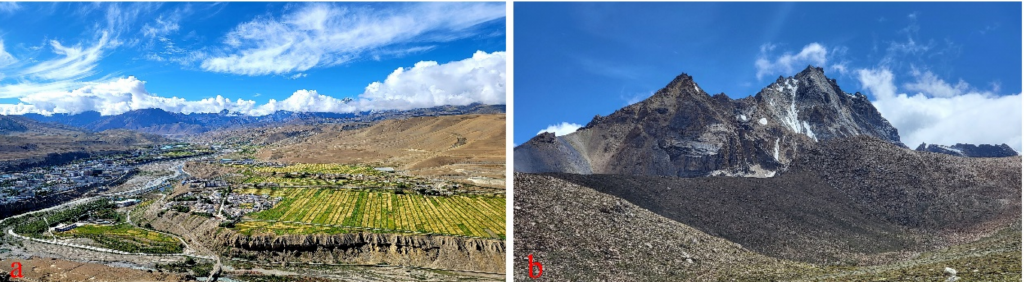
Figure 2. The landscape of Burang Town at different altitudes. ( a ): cropland; ( b ): alpine